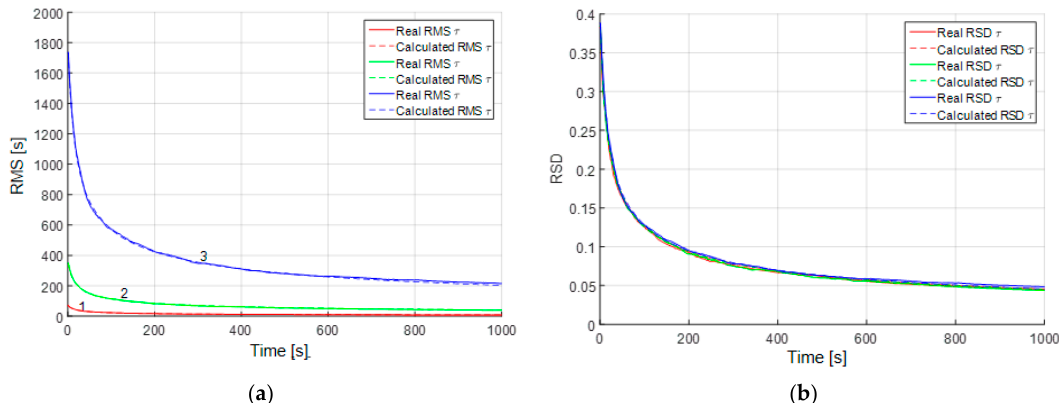
Figure 4. ( a ) Estimation error RMS for the correlation interval of the Markovian process with different initial uncertainties: 1 (red)— τ m ∈ [ 1 5 ] min, 2 (green)— τ m ∈ [ 5 25 ] min, 3 (blue)— τ m ∈ [ 25 125 ] min; ( b ) estimation error RSD for the correlation interval of the Markovian process with the same parameters.